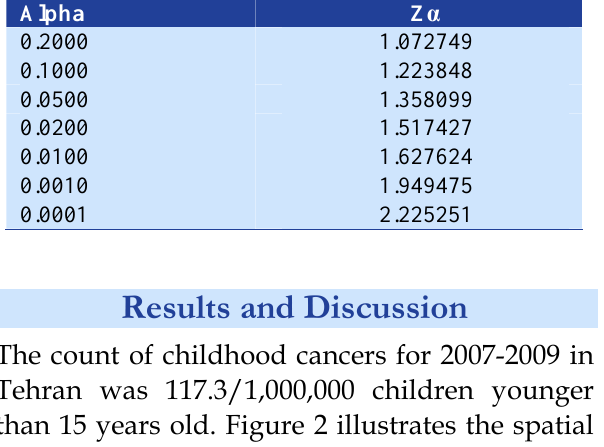
Table 1. The constant values (Z α ) for calculating the critical value of Kolmogorov-Smirnov test by different confidence intervals